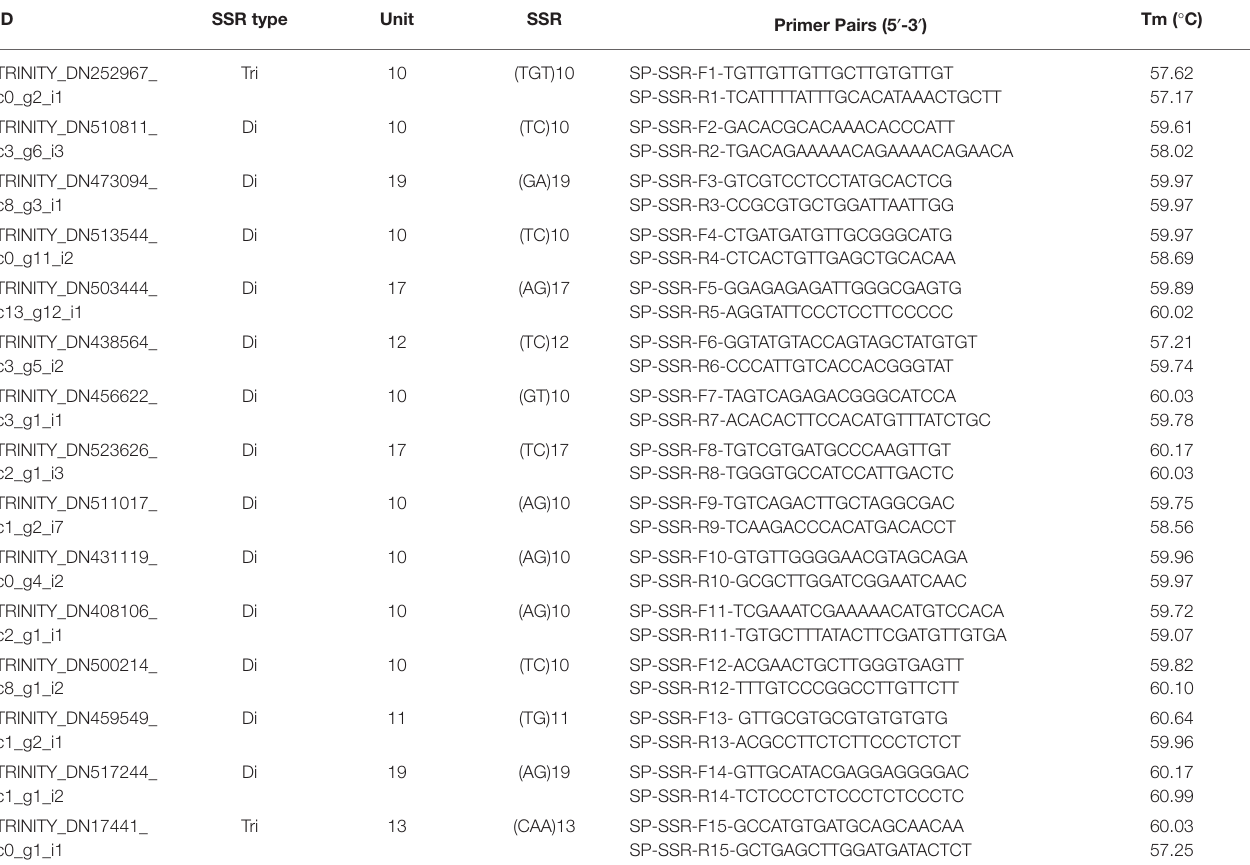
TABLE 4 | Details of randomly selected SSR markers (thirteen dinucleotide and two trinucleotide repeats) along with their primer sequence and melting temperature ranging from 57.17 ° C to 60.99 °